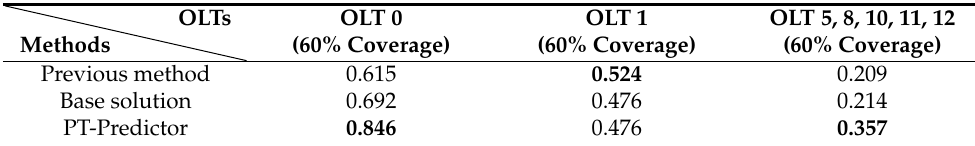
Table 2. Accuracy improvements on different